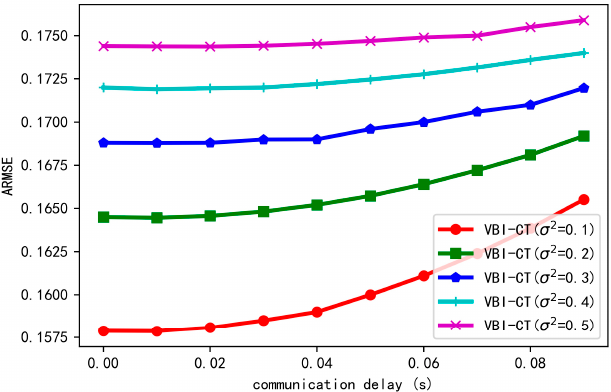
Figure 9. Tracking error of the proposed algorithm under different communication delays.